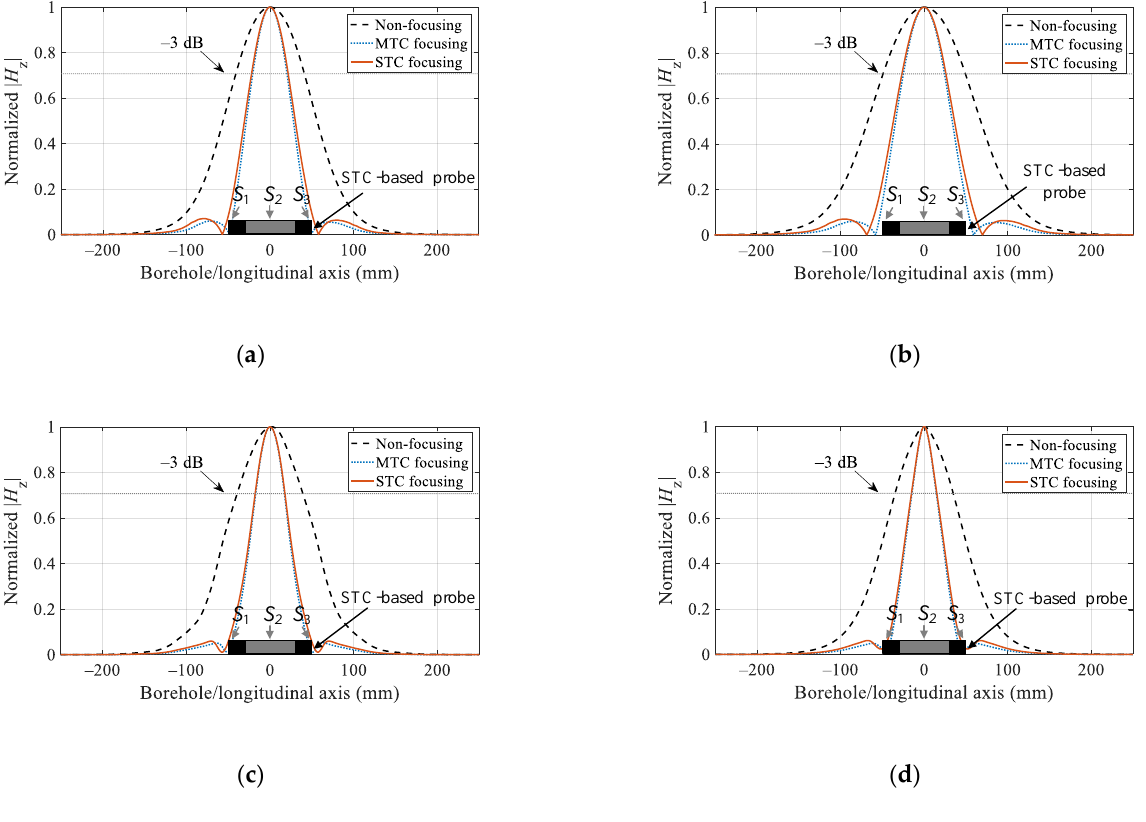
Figure 5. Longitudinal magnetic field distributions with no-MF, MTC-based MF, and STC-based MF: ( a ) r = 55.98 mm, t = 0 ms; ( b ) r = 55.98 mm, t = 10 ms; ( c ) r = 59.74 mm, t = 0 ms; and ( d ) r = 63.5 mm, t = 0 ms.